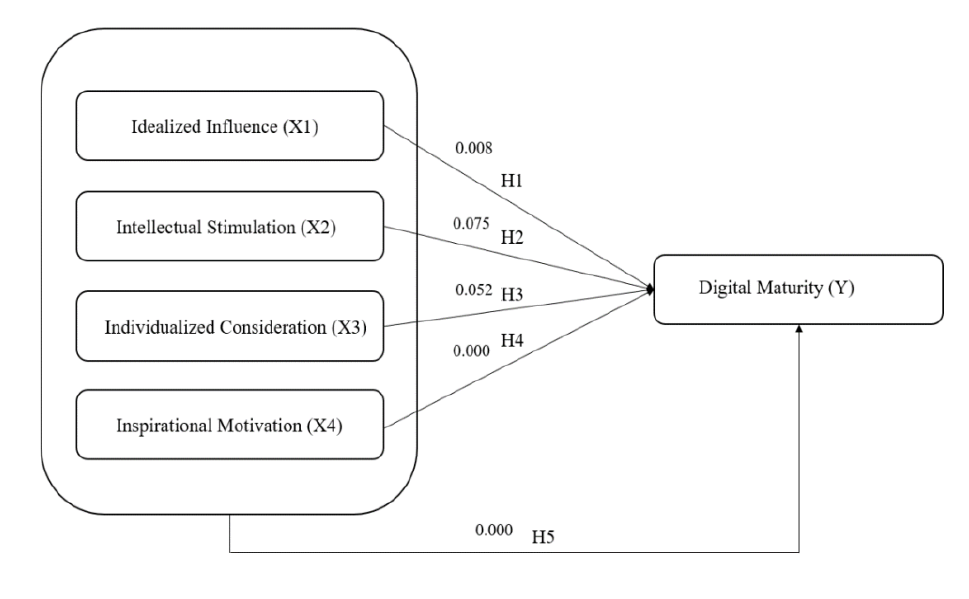
Figure 1: Result of T-test and